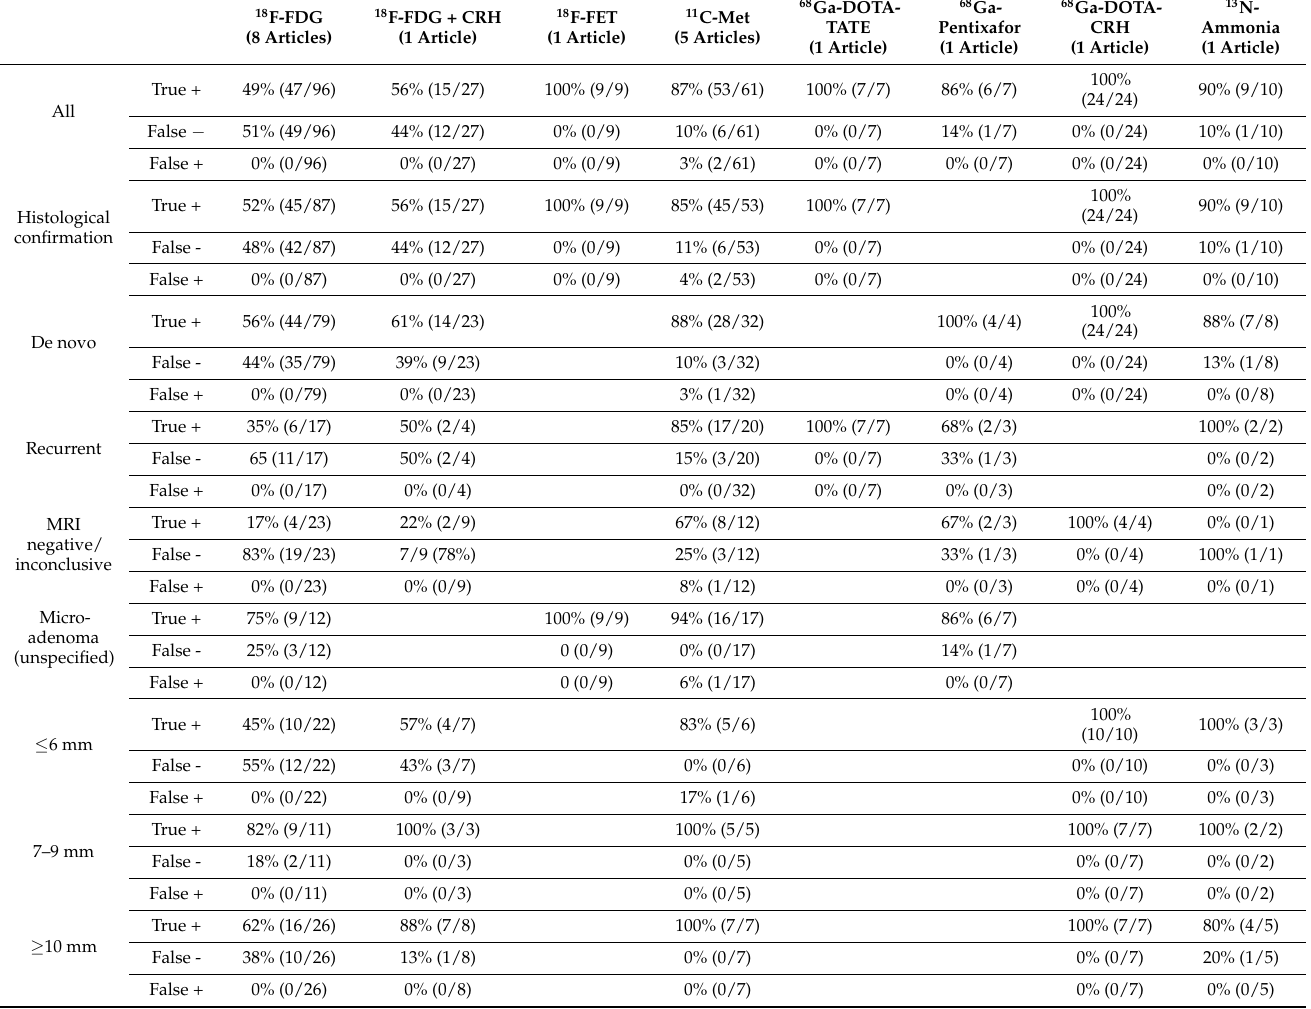
Table 2. Diagnostic accuracy of molecular imaging in Cushing’s